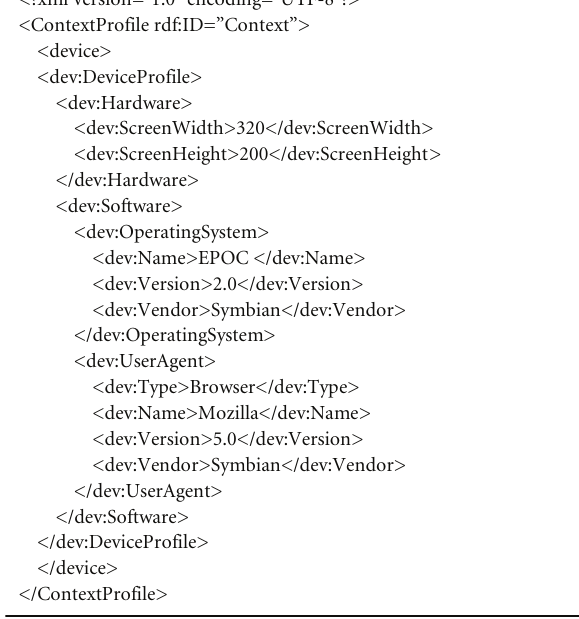
Figure 2: Partial example of context profile.